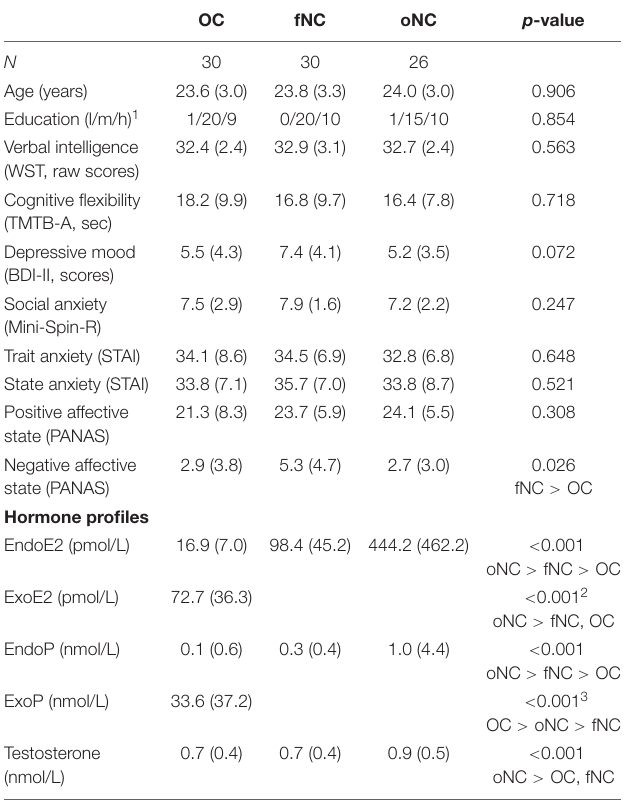
TABLE 1 | Sample characteristics (mean and standard deviation if not otherwise specified) and hormone profiles per group (median and interquartile range). OC fNC